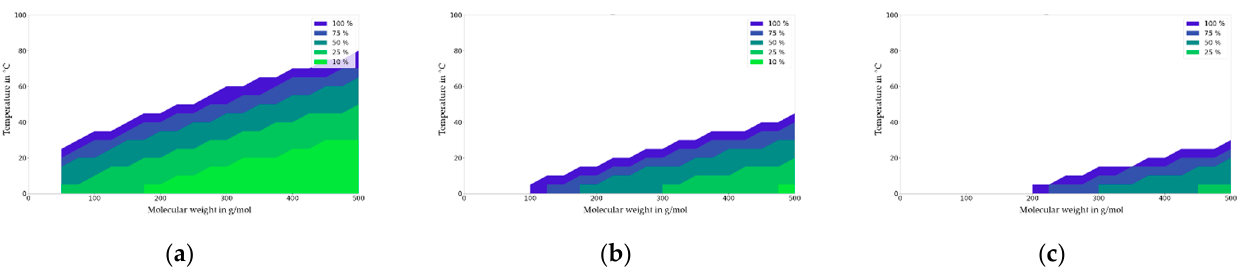
Figure 14. Migration map for PA6 for contact times of 1 h. ( a ) 0% relative humidity, ( b ) 50% relative humidity and ( c ) 100% relative humidity. Molecular weight in g/mol against temperature (T) in °C. Deviation of migration in mg/dm 2 in dependence from partition coefficient (K P,F ) expressed in % at a given initial concentration (1000 mg/kg), material thickness (2000 µm) and area to volume ration (6 dm 2 per kg food).